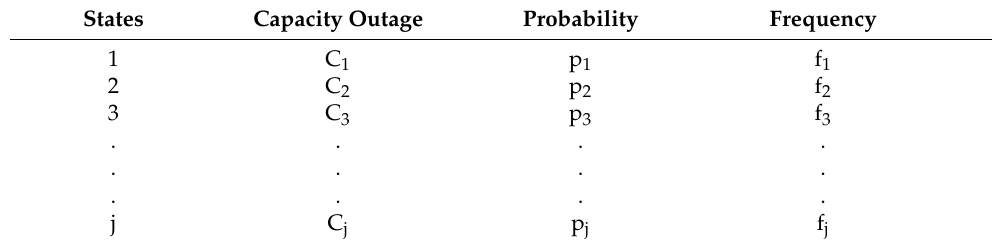
Table 5. Capacity outage probability